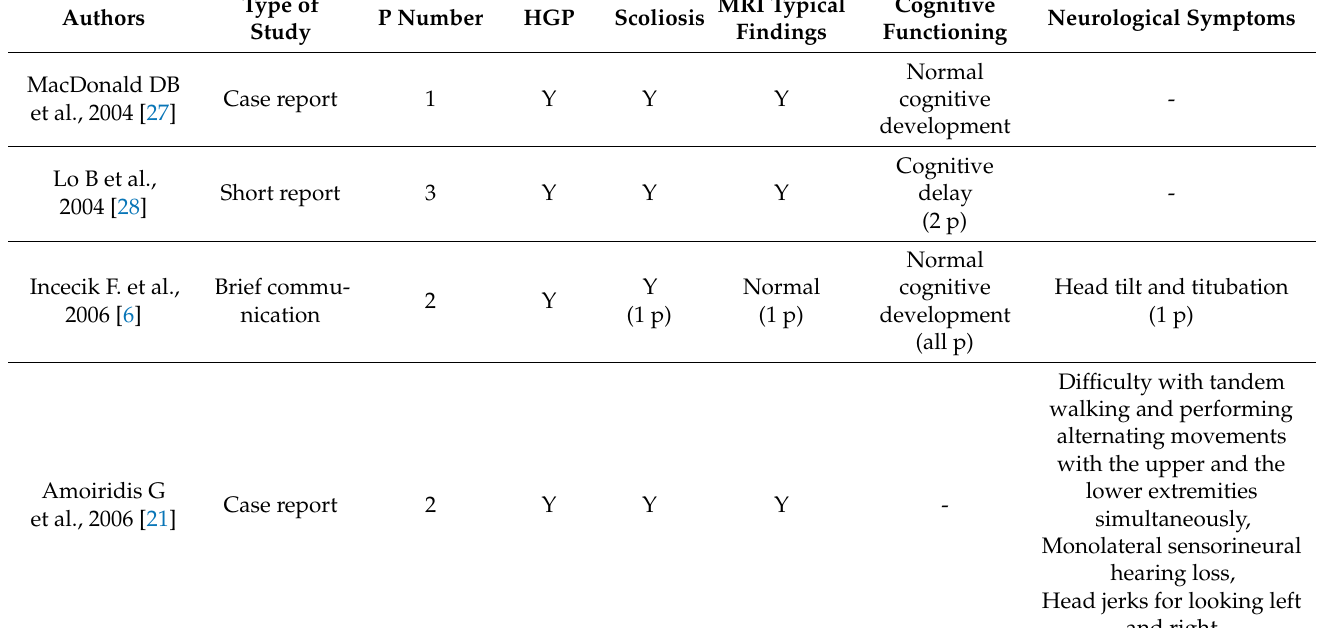
Table 1. Literature review on the neurocognitive symptom in HGPPS